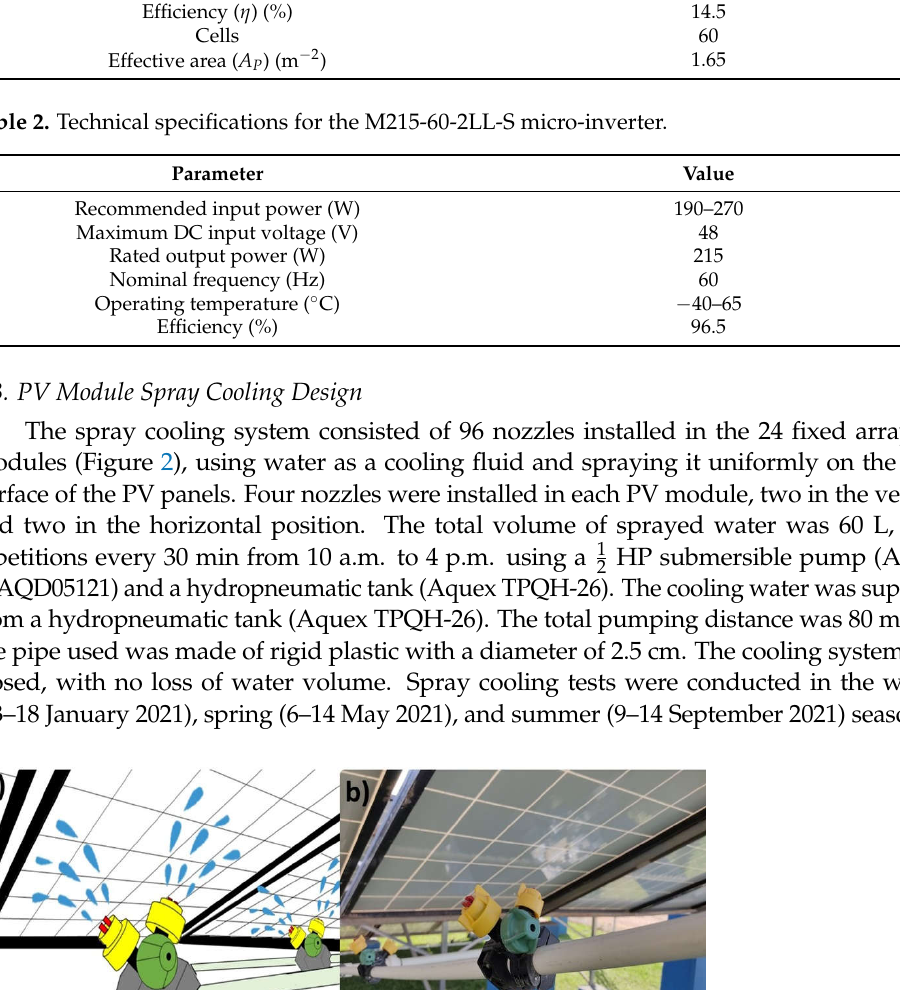
Table 2. Technical specifications for the M215-60-2LL-S micro-inverter.